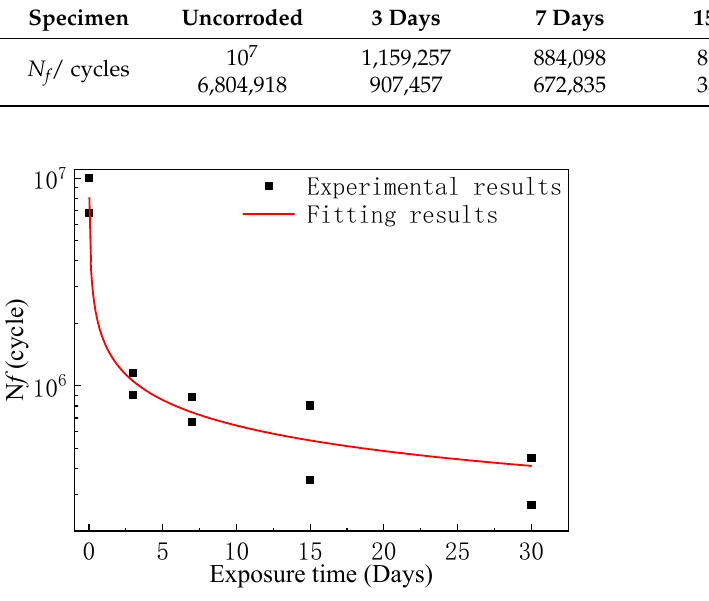
Table 2. Fatigue life of 5083/6005A welded joints.